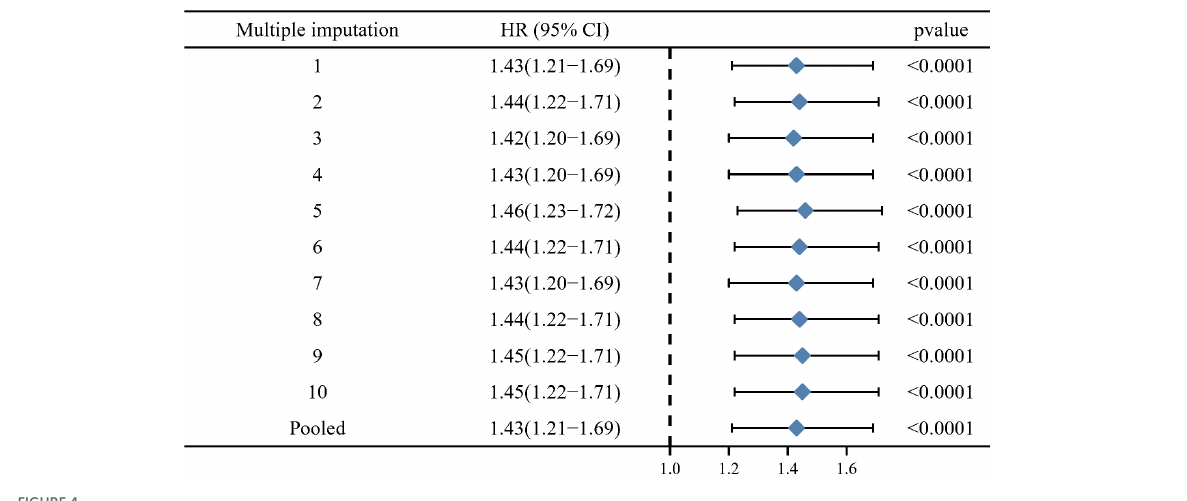
FIGURE4 Pooled results for multiple imputations (10 times) of missing